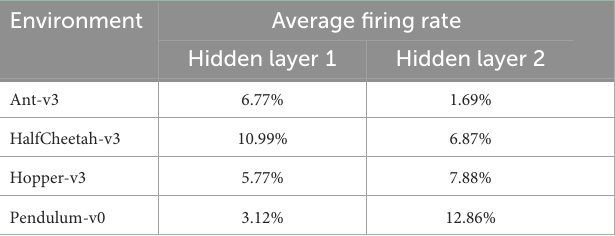
TABLE 4 Average firing rates in hidden layers one and two, measured for each environment over 100 evaluation